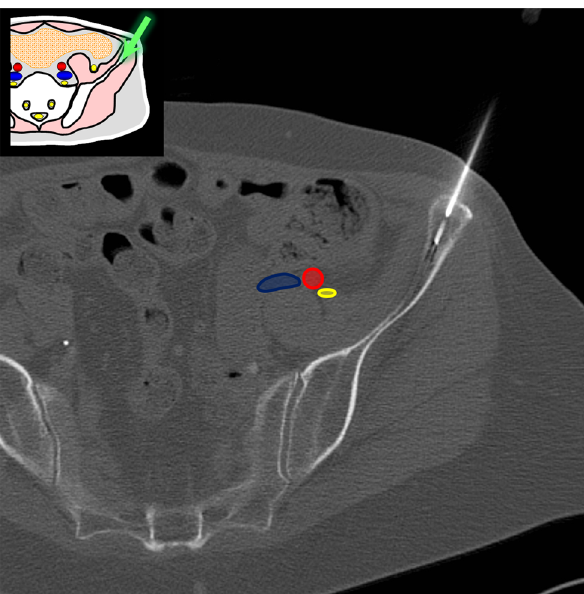
Fig. 4 A 69-year-old woman with clinical background of melanoma presenting with a new lytic lesion in the iliac bone. An anterolateral approach through the anterior-superior iliac spine was used to perform a biopsy using a coaxial 16-G cutting needle confirming melanoma